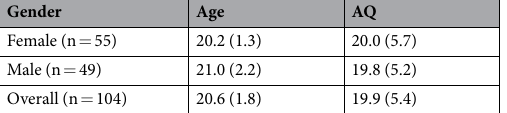
Table 1. Subject Characteristics. Mean (standard